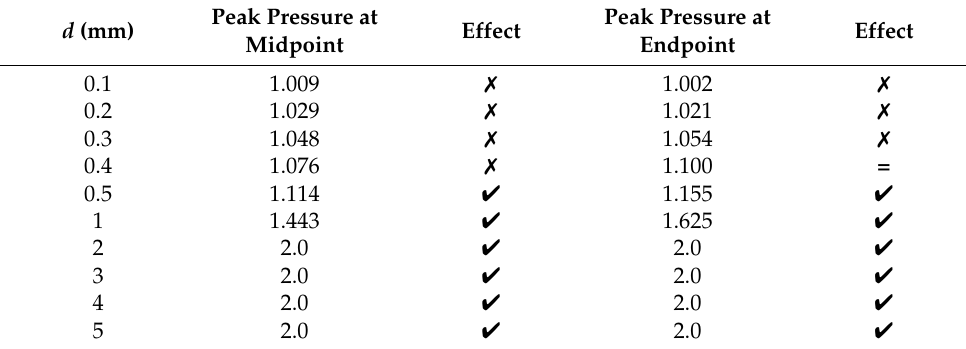
Figure 9. Normalized pressure–time curves at inlet, middle point and endpoint, where L x = 10 m and f = 25 Hz: ( a ) d = 0.1 mm, ( b ) d = 1 mm, ( c ) d = 10 mm. f = 25 Hz: ( a ) d = 0.1 mm, ( b ) d = 1 mm, ( c ) d = 10 mm. Table 1. Inhibition or magnification effects of the pulse at midpoint and endpoint (partial